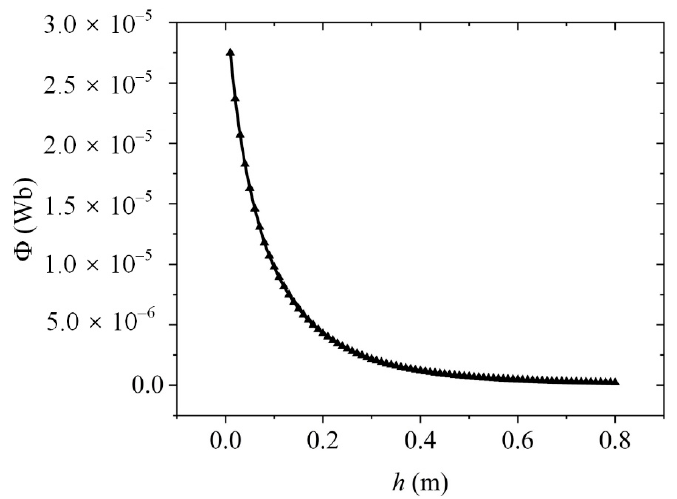
Figure 3. Relationship between the transmission distance h and the magnetic flux Φ .